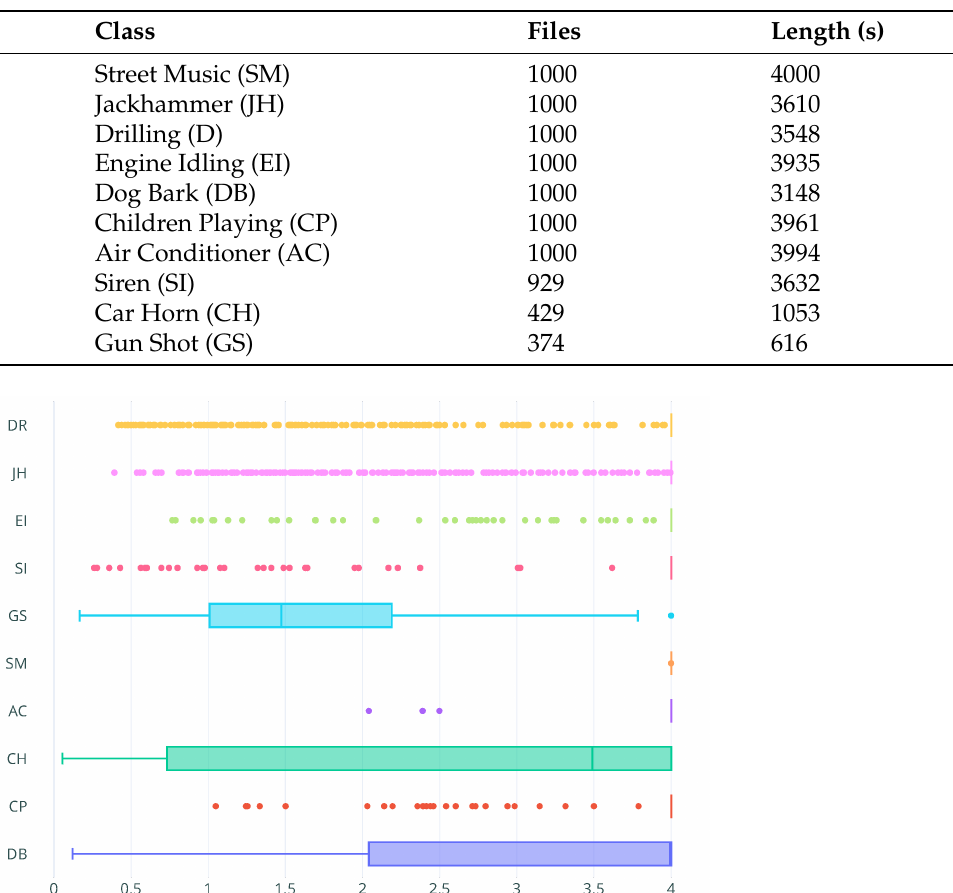
Table 1. UrbanSound8k Dataset composition.